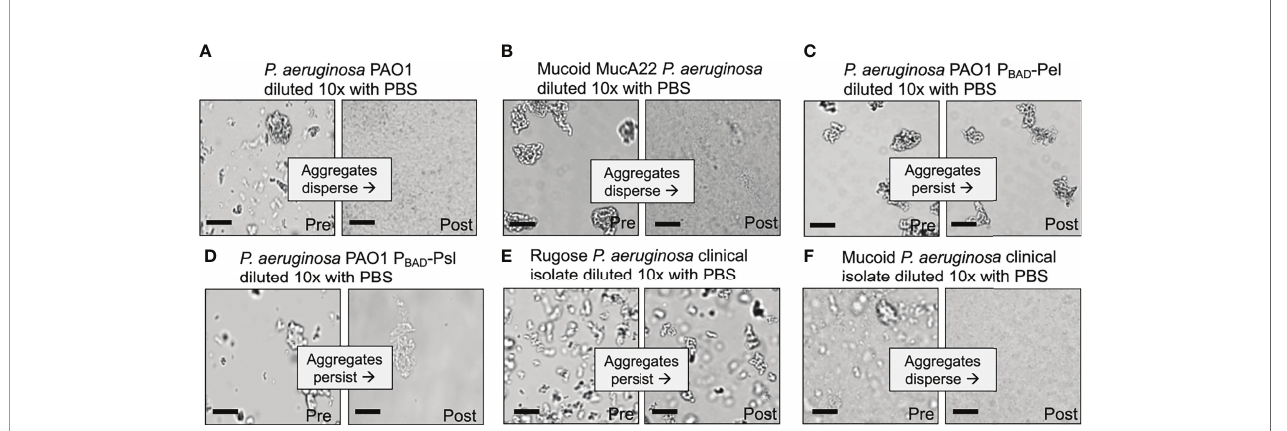
FIGURE 2 | Depletion aggregate dispersal phenotypes of P. aeruginosa laboratory strains and CF clinical isolates. (A – F) Aggregate dispersal of the indicated strains and isolates was measured. Depletion aggregation was induced with 30% w/vol PEG 35 kDa for 18 hours. Depletion aggregates were then diluted 10X with PBS and representative images were acquired immediately pre- and immediately post-dilution. Scale bar 40